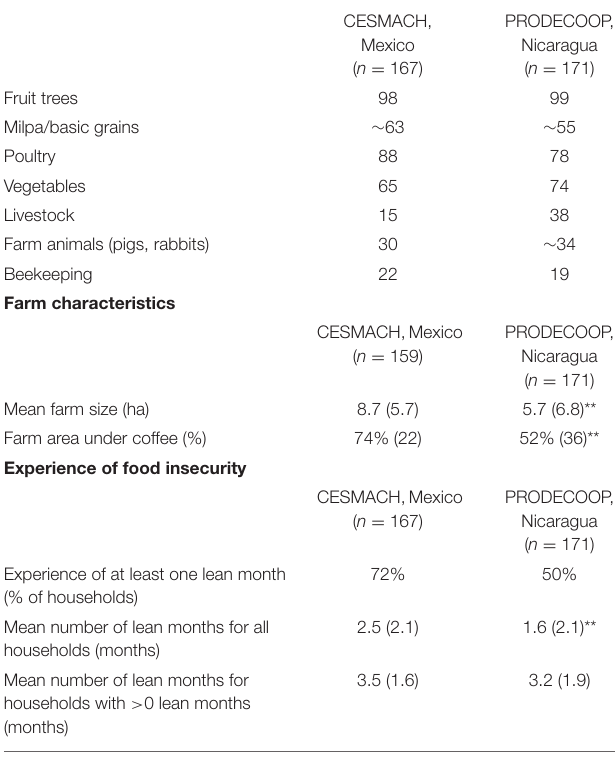
TABLE 2 | Engagement in diversification, farm characteristics and prevalence of food insecurity for study cooperatives. Engagement in diversification activities in the P1 survey (% of